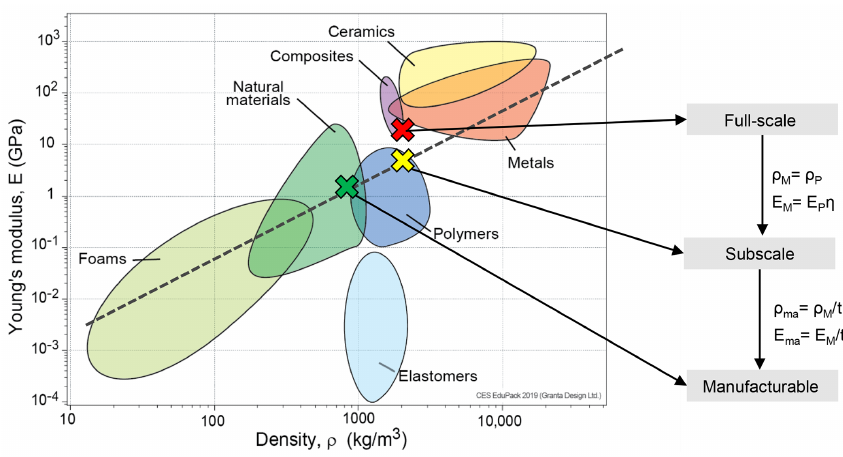
Figure 3. Ashby’s diagram of Young’s modulus vs. density (Cambridge University Engineering Department, 2003), and the outer shell skin